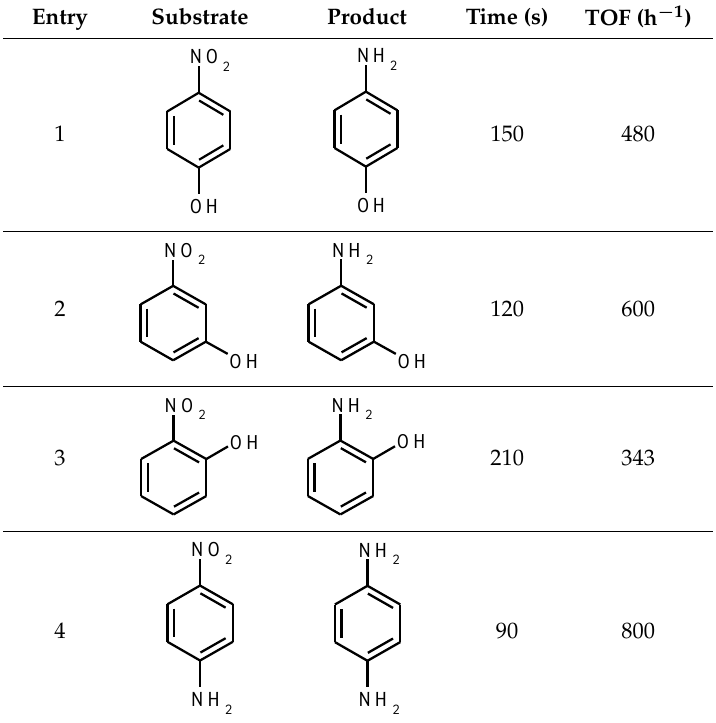
Figure 7. Time-dependent UV-vis absorption spectra for the reduction of 4-NP over different amount of catalyst, 0 mol % ( a ); 2.5 mol % ( b ); 5 mol % ( c ); and Plot of ln( C t / C 0 ) versus time for the reduction of 4-NP with different amount of catalyst ( d ).